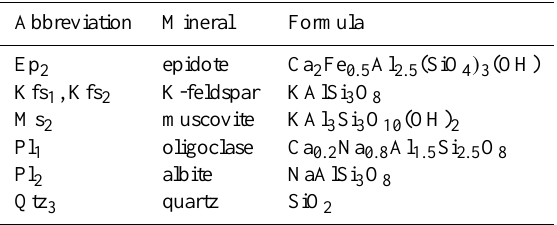
Table 1. Abbreviations and chemical formulaes for the minerals as used in the reaction